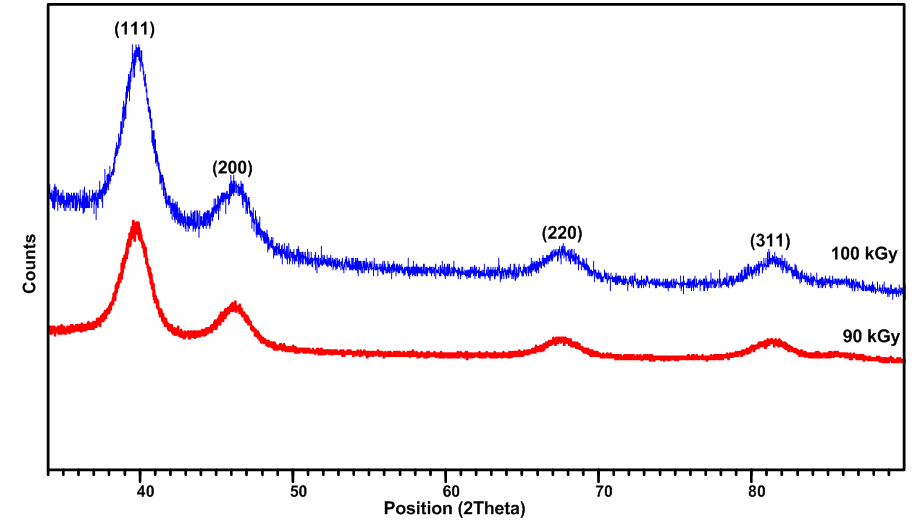
Figure 3. XRD patterns of colloidal Pt nanoparticles synthesized by the radiolytic method at doses of 90 and 100 kGy showing 2 θ values of 39.8, 46.2, 47.5, 67.5, and 81.4 which match perfectly with the (111), (200), (220), and (311) crystalline planes respectively for the face centered cubic